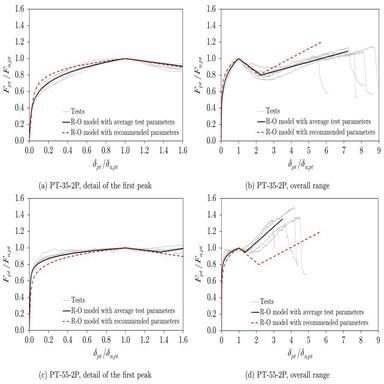
Comparisons of the proposed model using test and recommended predicted input parameters with test curves for double-board specimens.